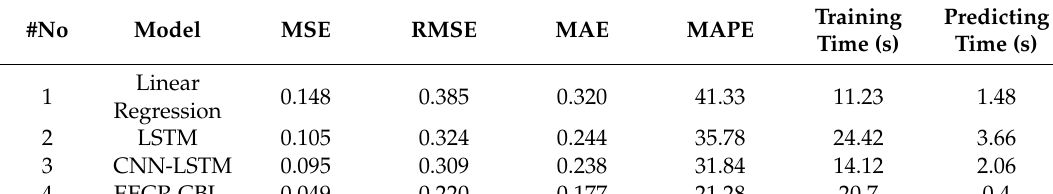
Table 6. Performances of the experimental methods for weekly dataset.